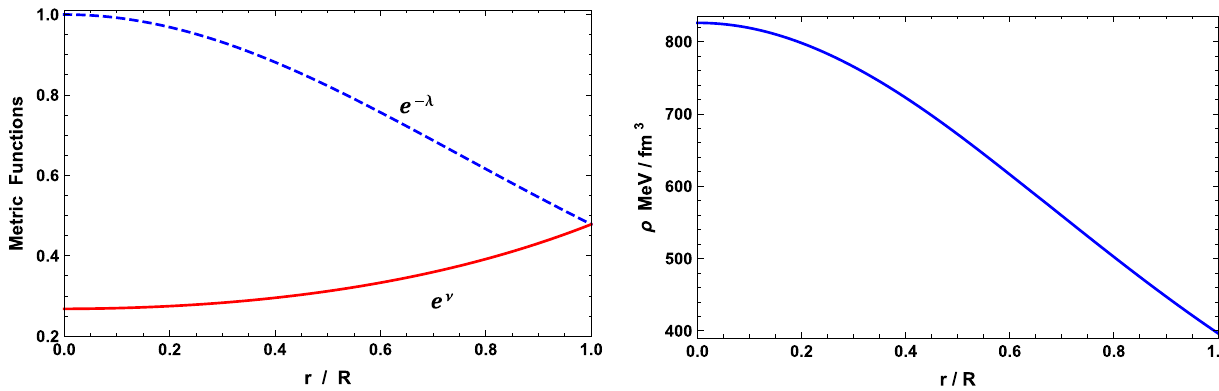
Fig. 1 The metric potentials and matter density for PSR J1903+327 plotted against r / R by taking Φ 0 = 1 . 001134 , ω = 5 , m φ = 0 . 002 , B =